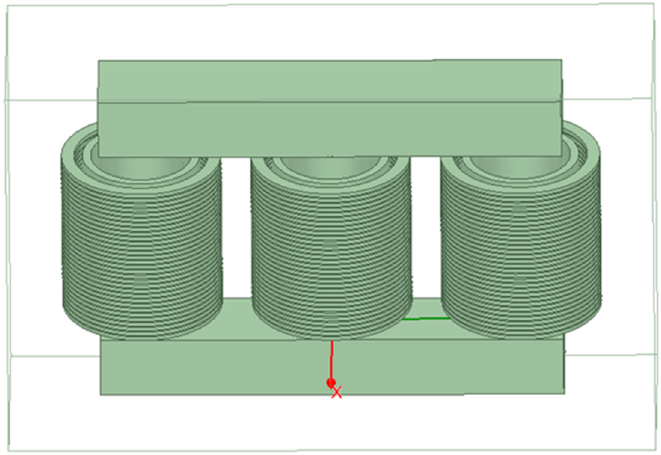
Figure 4. Three-dimensional model of transformer winding.